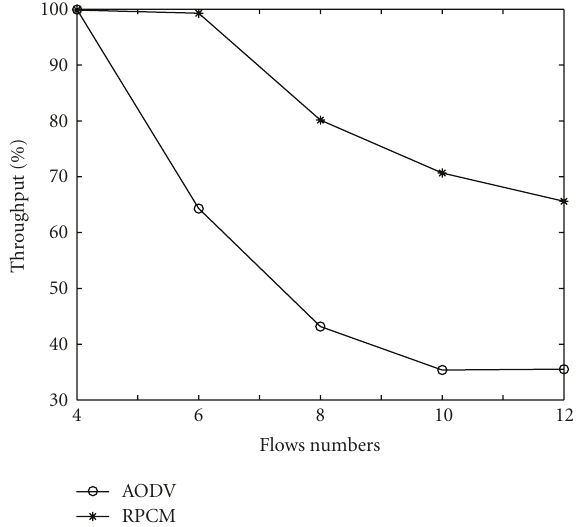
Figure 9: Performance of AODV and RPCM in terms of through- put, when ρ = 4(nodes / m 2